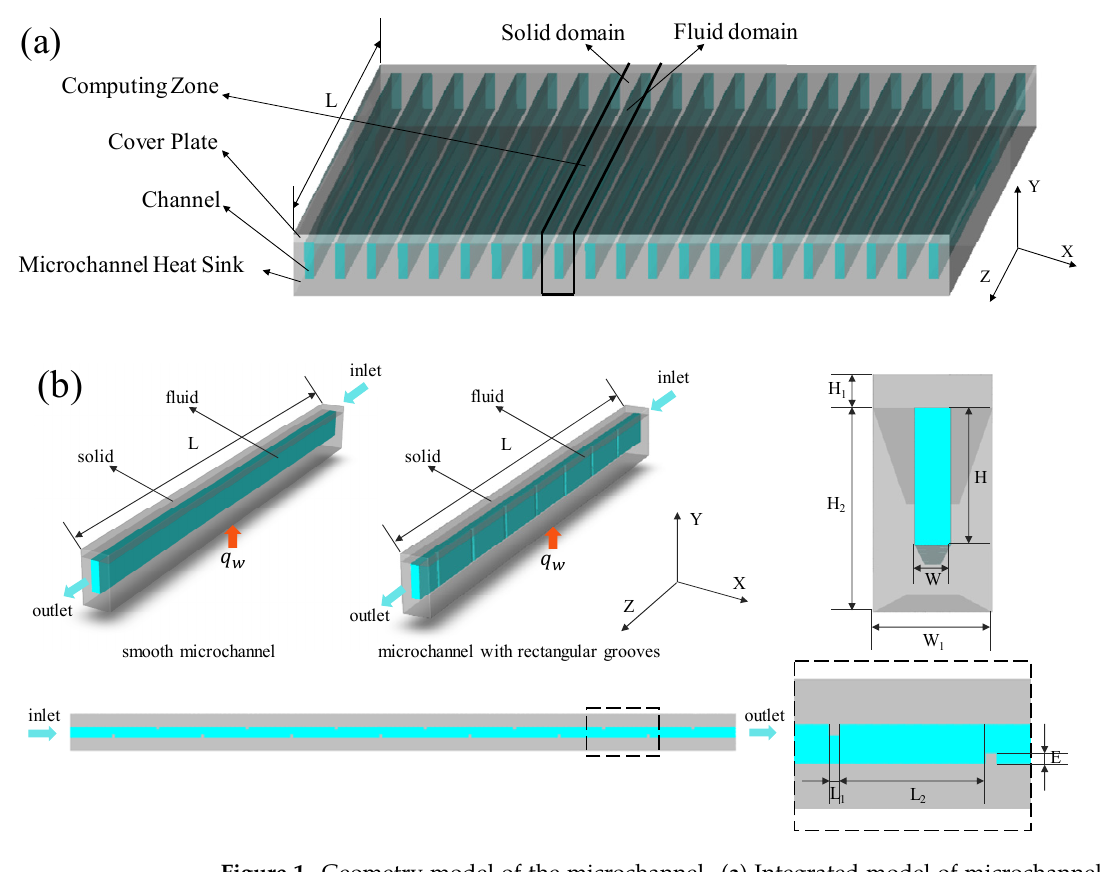
Figure 1. Geometry model of the microchannel. ( a ) Integrated model of microchannel heat sink. ( b ) Schematic diagram of computing zone for microchannel heat sink. Table 1. Dimensions of the SMC and RGMC